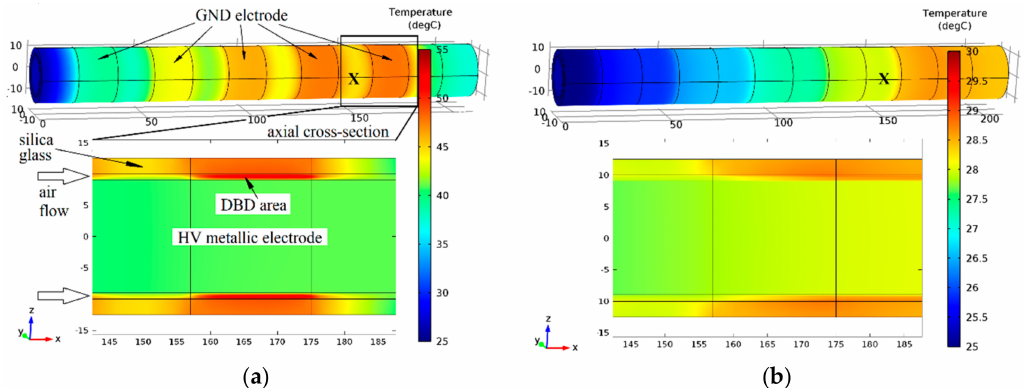
Figure 10. Thermal FEM simulation results for a simplified volume DBD OG model: ( a ) temperature distribution for 1 Nl / min airflow and 8.1 W active power supply, ( b ) for 100 Nl / min and 8.8 W (all spatial dimensions in